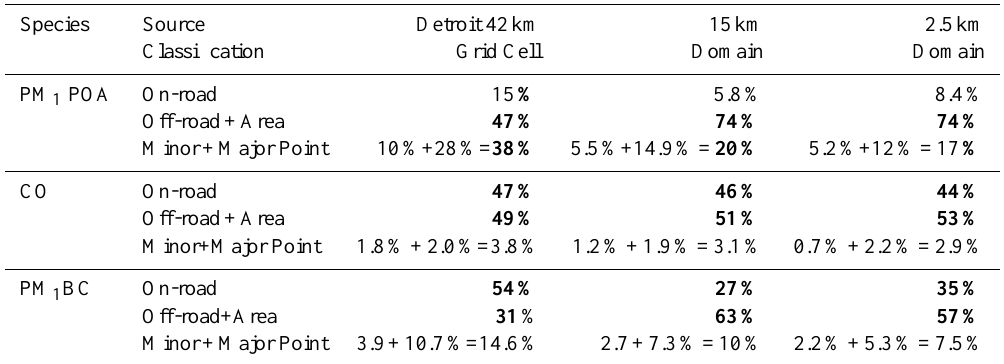
Table 3. Percentage emission source contributions for different model domains (PM emissions are for PM 1 size range) for July on Monday at 17:00UTC (12:00EST).